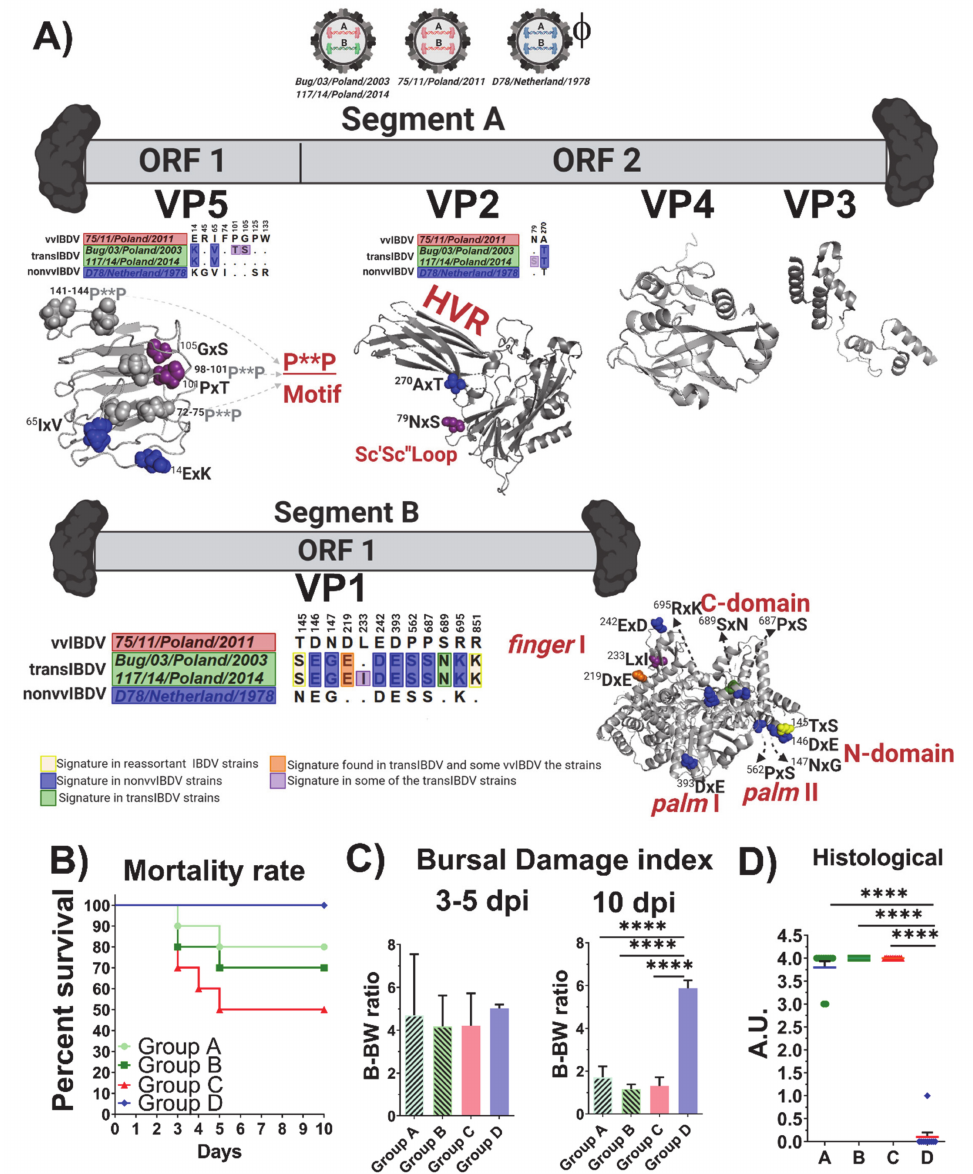
Figure 5. Molecular and biological comparison between the novel IBDV reassortant (vvIBDV-A/transIBDV-B) strains and vvIBDV (vvIBDV-A/vvIBDV-B) strains. ( A ) Schematic representation of the genome characteristic of the novel reassortant strains, the vvIBDV strain used in the experimental infection study, and the attenuated IBDV strains ( φ only used for comparison purposes in the molecular features) are shown. The representations of both genome segments A and B are presented, all of the molecular signatures found in the ORF encoding regions are denoted in the alignment, and the positions are denoted. All of the amino acid replacements found in the mature protein were denoted in the 3D structure for each protein. All of the amino acid replacements in the 3D structure were denoted using spheres and using the same color code presented in the amino acid alignments. For the VP5 protein, the model generated by [45] and kindly provided by Dr. Ganguly was used, and for the remaining proteins VP2: 2DF7, VP3: 2Z7J, and VP4: 4IZJ PDB, cartons were used. All of the functional domains were amino acid replacements, shown by the novel reassortant strains, are denoted. ( B ) Survival curves of the challenged SPF chickens; different curves indicated different groups, and each group was denoted. ( C ) Estimated bursa damage index determined to 3–5 dpi in the left panel and 10 dpi in the right panel. ( D ) Histological overall scoring. In all cases, significant differences by Brown–Forsythe and Welch ANOVA for multiple comparisons with a Dunnett’s T3 multiple comparisons were denoted (**** p < 0.0001). In all cases, the groups are denoted (Group A: animals inoculated with the reassortant strain Bug/03/Poland/2003, Group B: animals inoculated with the reassortant strain 117/14/Poland/2014, Group C: animals inoculated with the very virulent reference strain 75/11/Poland/2011, and group D: control